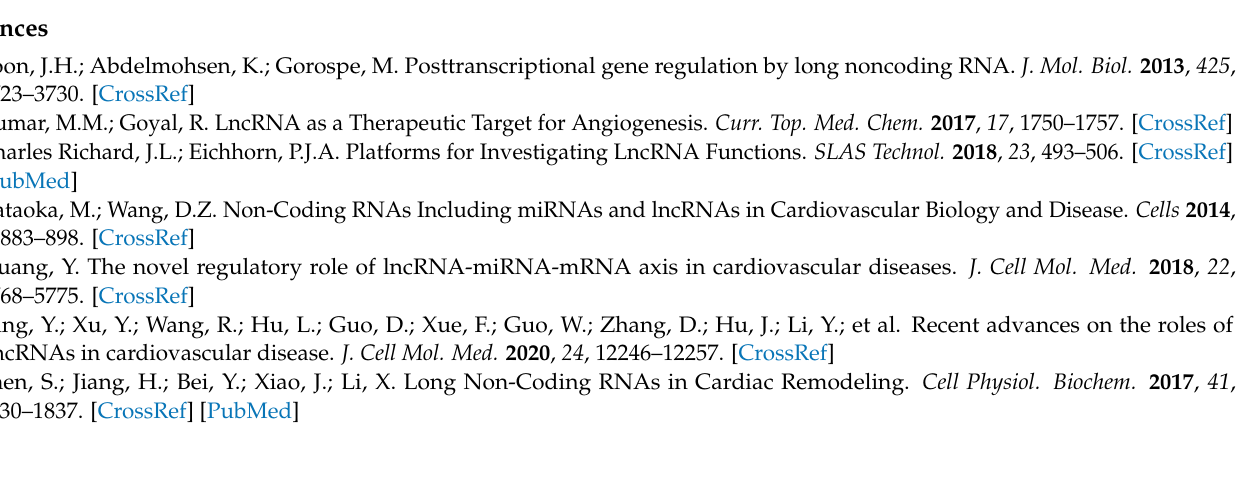
WAG rats. Supplementary Table S3. Pearson’s coefficients of correlation between lncRNAs’ and DEGs’ expression. Supplementary Table S4. GO terms for biological processes and related DEGs whose transcription correlates with Snhg4 expression. Supplementary Table S5. GO terms for biological processes and related DEGs whose transcription correlates with LOC100910237 expression. Supplementary Table S6. GO terms for biological processes and related DEGs whose transcription correlates with Tnxa-ps1 expression. Supplementary Table S7. GO terms for biological processes and related DEGs whose transcription correlates with RGD1562890